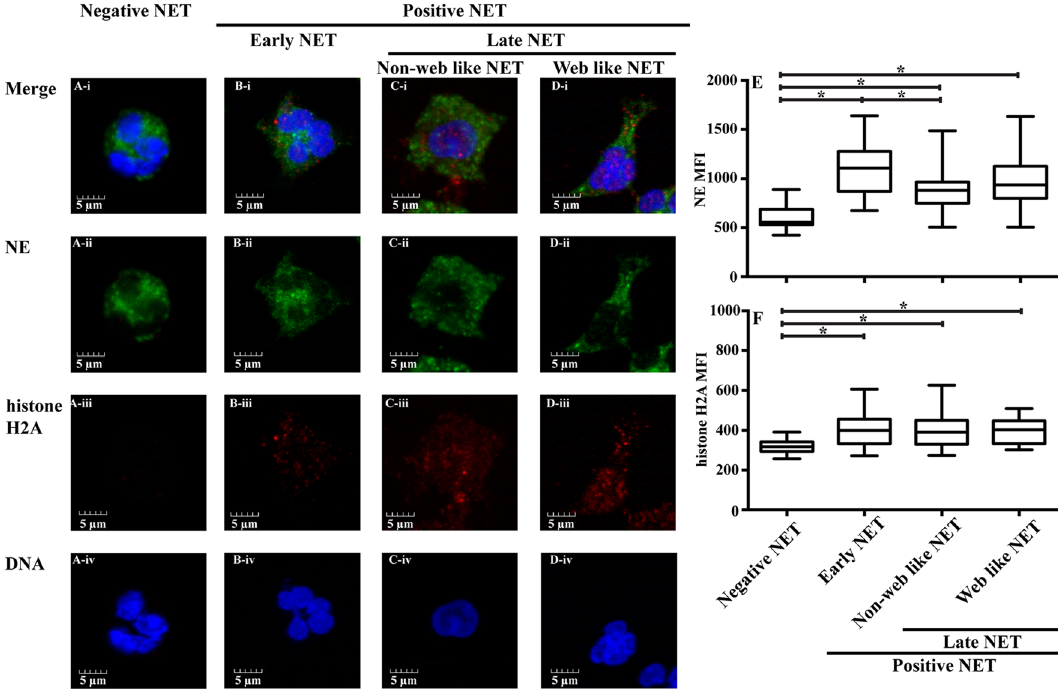
Figure 2. Confocal microscopic analysis of NET morphology. ( A – D ) Representation of confocal microscopic analysis of neutrophils from normal subject with ( A ) the absence or ( B – D ) the presence of combined 100 ng/ mL PMA and 100 ng/mL LPS for 90 min at 37 °C, 5% CO 2 . The neutrophils were stained with fluorochrome conjugated antibodies specific to neutrophil elastase (NE, green), histone H2A (red) and nuclear DNA (blue) to analyze mean fluorescent intensity (MFI) and morphology that can identified as ( Ai–iv ) Negative NETs and ( B – D ) positive NETs for ( Bi–iv ) early phase, ( Ci–iv ) late phase with non-web like structure and ( Di–iv ) late phase with web-like structure. MFI of ( E) NE and ( F ) histone H2A of different stages of NETs was analyzed from isolated neutrophils from 2 normal subjects, 2 non-splenectomised β-thalassaemia/HbE patients and 2 splenectomised β-thalassaemia/HbE patients that were incubated in the absence or the presence of combined 100 ng/mL PMA and 100 ng/mL LPS for 90 min at 37 °C, 5% CO 2 . A total of 30 neutrophils per NET stage (5 neutrophils per stage per subject) were examined from untreated and PMA/LPS-treated neutrophils for negative and positive NET, respectively. *; significant difference at P < 0.01 using a non-parametric Mann– Whitney U Test. i; merge, ii; anti-neutrophil elastase, iii; anti-histone H2A, iv; 4 ′ , 6-diamidino-2-phenylindole, dihydrochloride (DAPI), LPS; lipopolysaccharides and PMA; phorbol 12-myristate